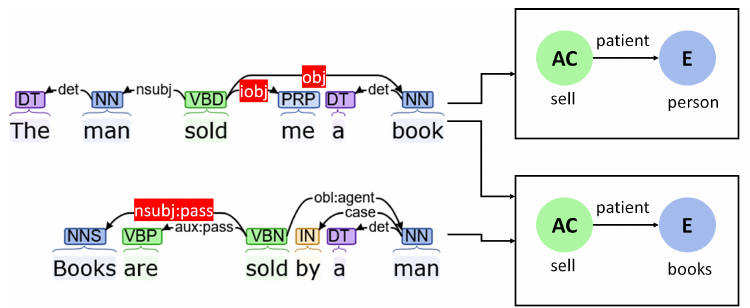
Figure 6. Various ways to create “patient” edges from